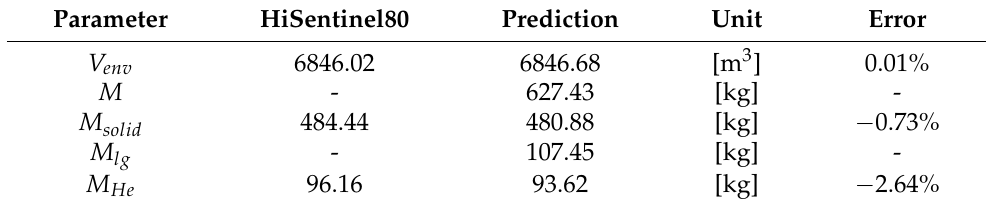
Table 5. Comparison between HiSentinel80 and methodology predictions.